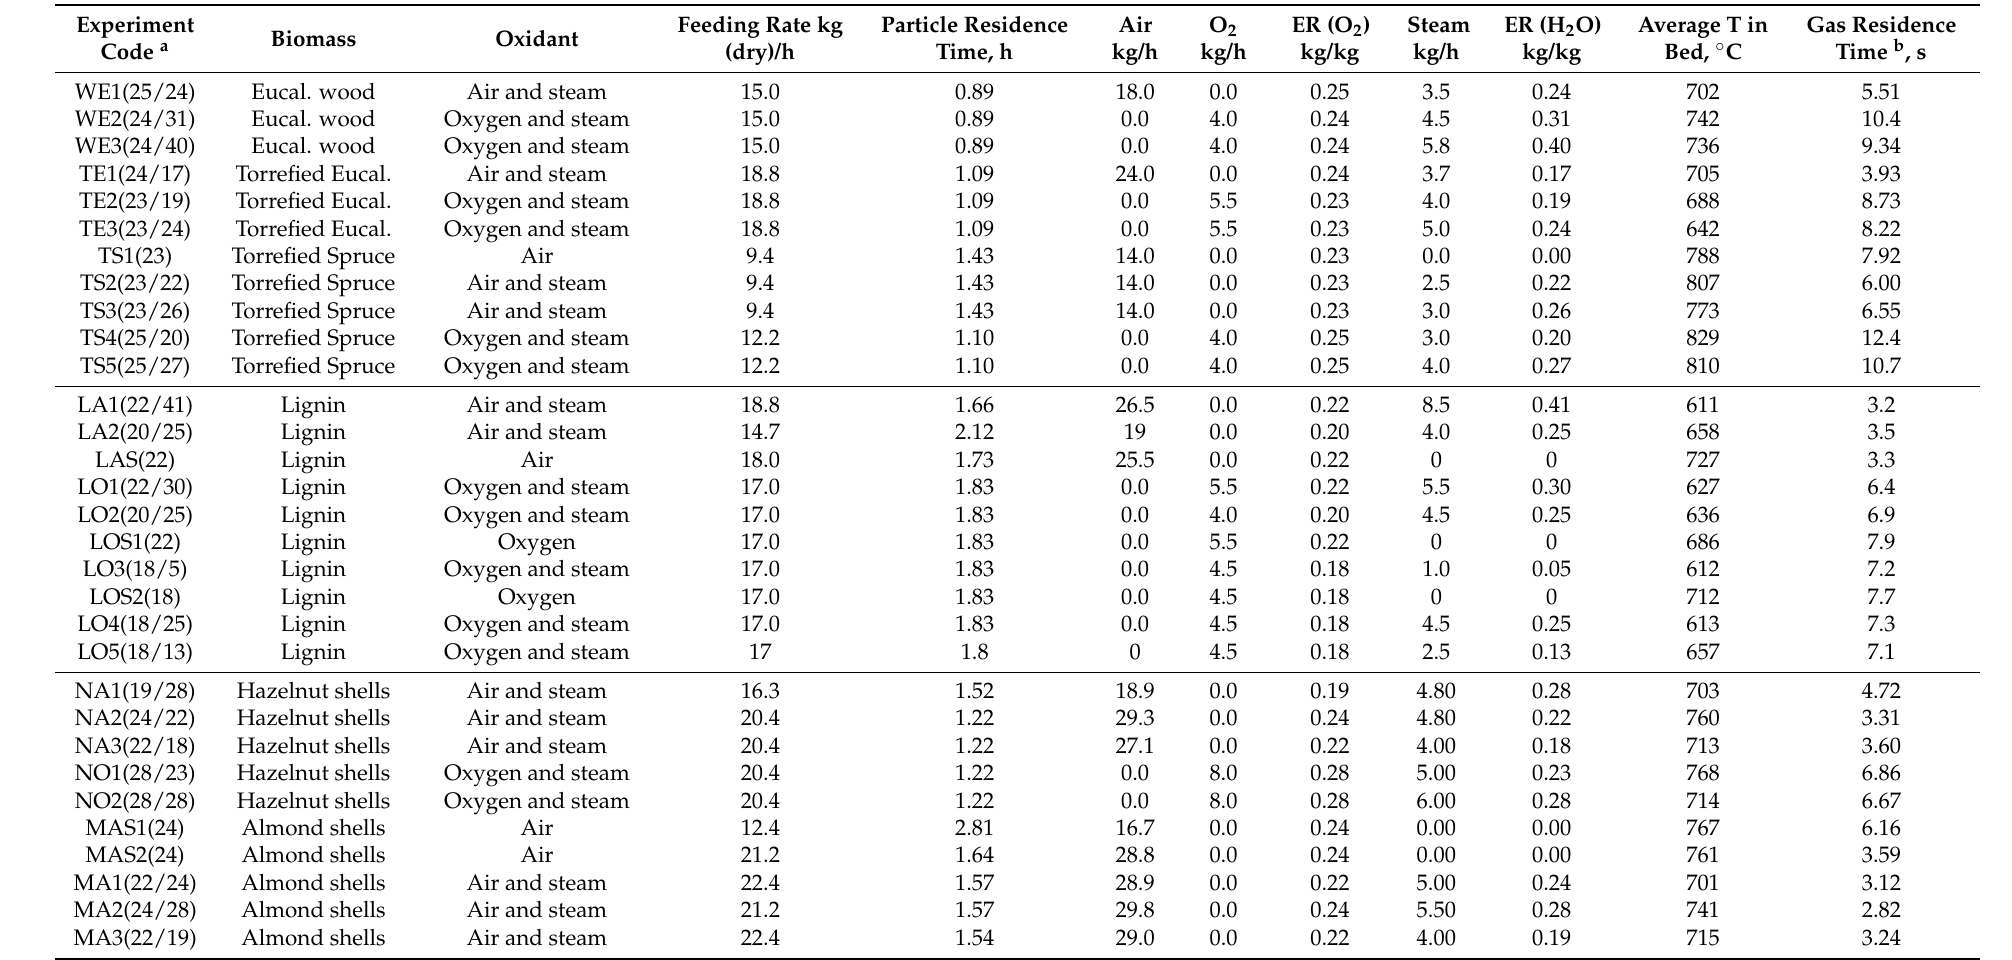
Table 6. Experimental matrix and gasification parameters